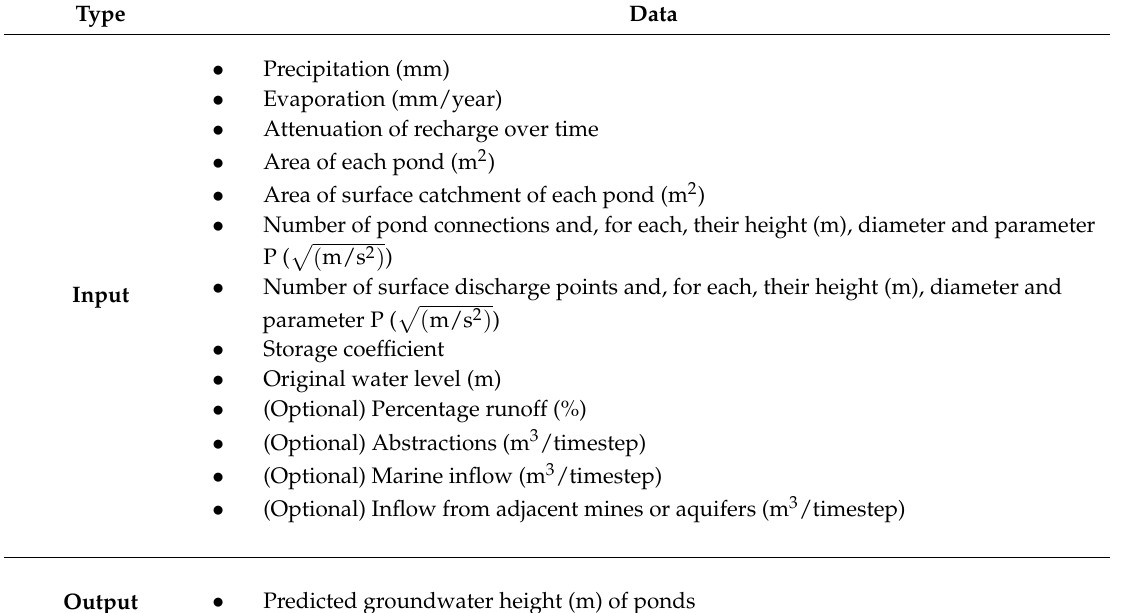
Table 1. SIMPL program input and output data.